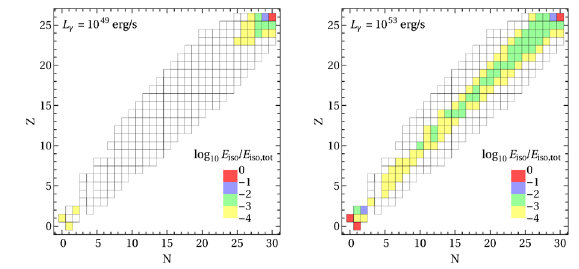
Figure 1. Isotope chart depicting the development of the nuclear cascade in the source for di ff erent luminosities and pure 56 Fe in- jection. The color code indicates the energy per isotope relative to the total isotropic equivalent energy. Note that the size of the region is kept constant. Figure taken from